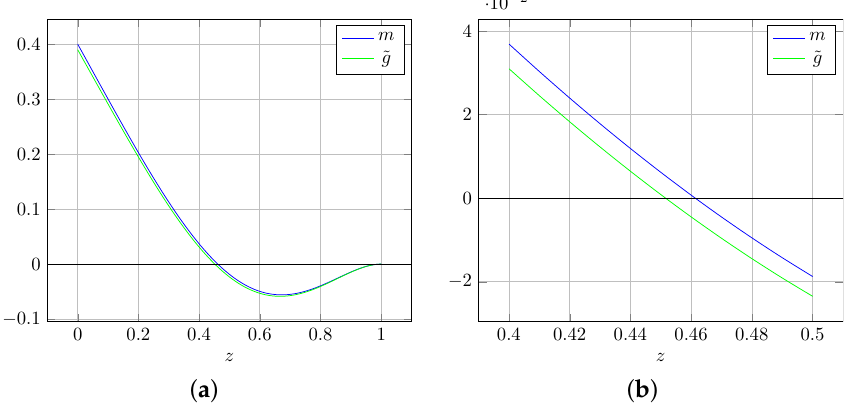
( 0,1 ) , ( b ) Zoom in the ∈